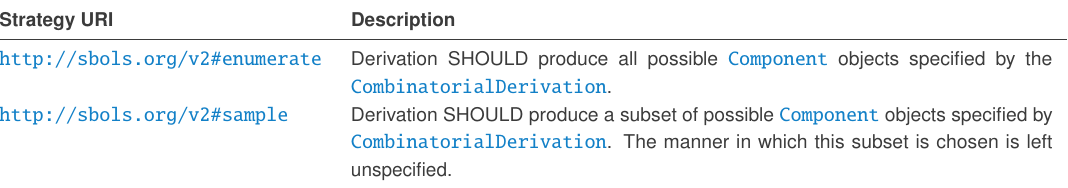
Table 12: REQUIRED URI s for the strategy